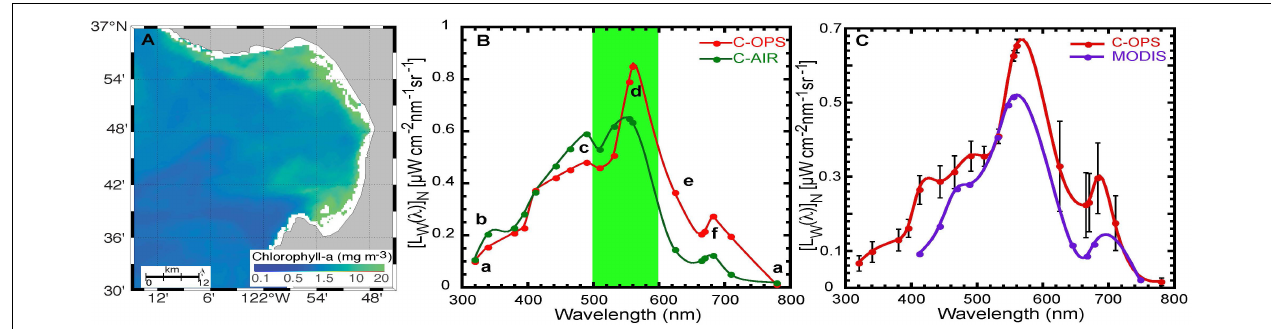
FIGURE 6 | MODIS Aqua Chl a from 5 November 2013 (OCEANIA) is shown in (A) , processed at 250 m resolution, with a comparison of C-OPS (in-water) and C-AIR (airborne) within the red tide in (B) , and the corresponding C-OPS versus MODIS data in (C) processed at 1 km resolution. Error bars in (C) represent the standard deviation of three consecutive C-OPS profiles. Station location is indicated in Figure 2A (solid circle).